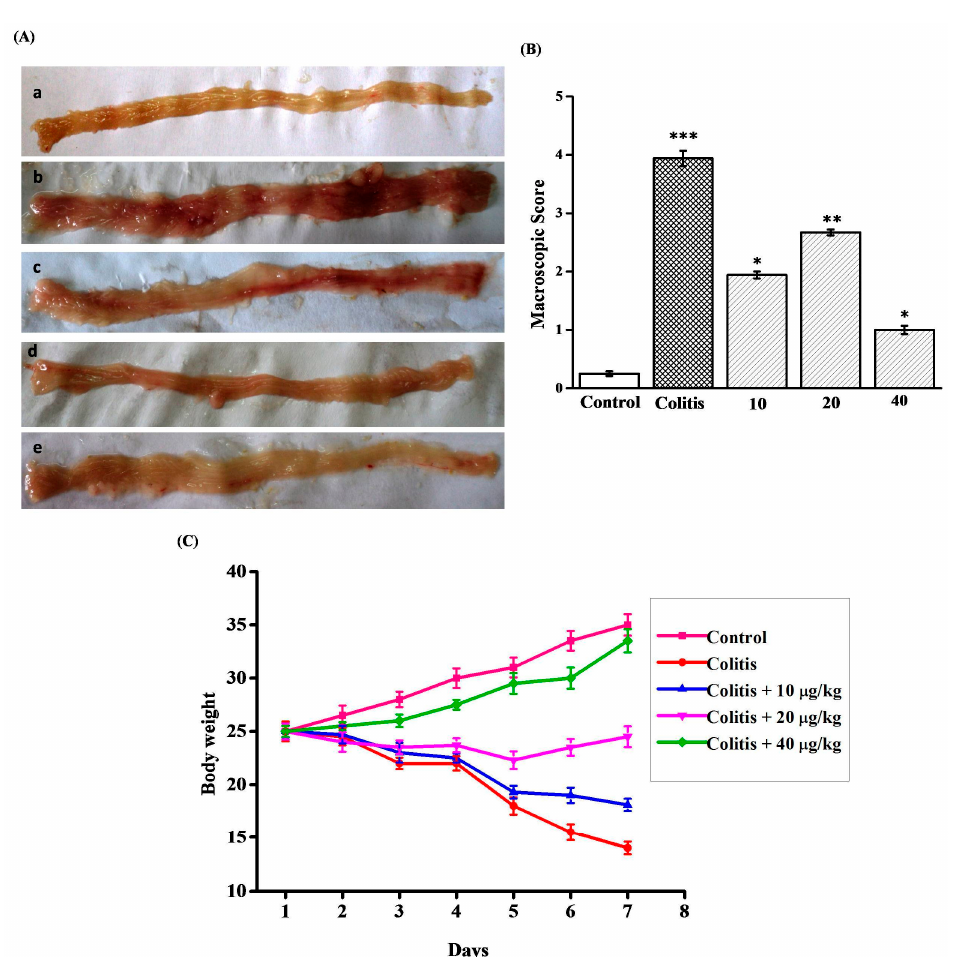
Figure 3. Therapeutic effect of Sal B on the body weight changes of mice with colitis. ( A ) The mice were given only saline (a. control group), saline containing 5% AA (b. colitis group 2), AA + 10 µ g/kg Sal B (c. group 3), AA + 20 µ g/kg Sal B (d. group 4), AA + 40 µ g/kg Sal B (e. group 5), ( A ) Representative morphological changes of colon tissues. In each group, colon samples were collected from mice. Interestingly, Sal B decreased the degree of ulcer index and colon shortening in a dose-dependent manner. ( B ) Macroscopic assessment of colons from AA-induced experimental colitis. ( C ) Effect of daily treatment with Sal B changes in body weight in experimental colitis. AA-acetic acid; Sal B-Salvianolic acid B, * p < 0.05, ** p < 0.01, *** p < 0.001 as compared with control.